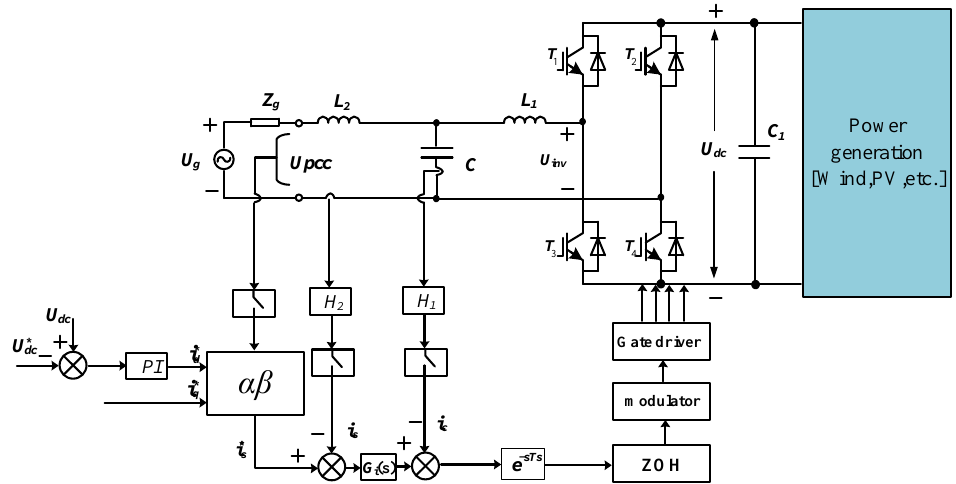
Figure 1. Structure diagram of LCL -Type grid-connected converter without PLL in weak gird con- ditions.